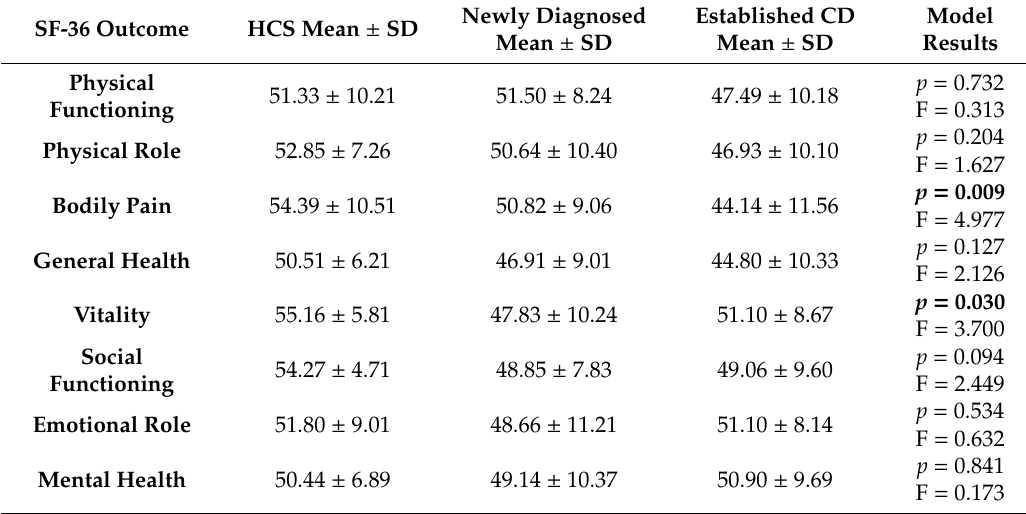
Table 4. Results of “major group” ANCOVA analyses (controlling for age) comparing outcomes from the SF-36 between controls, newly diagnosed CD cases and established CD